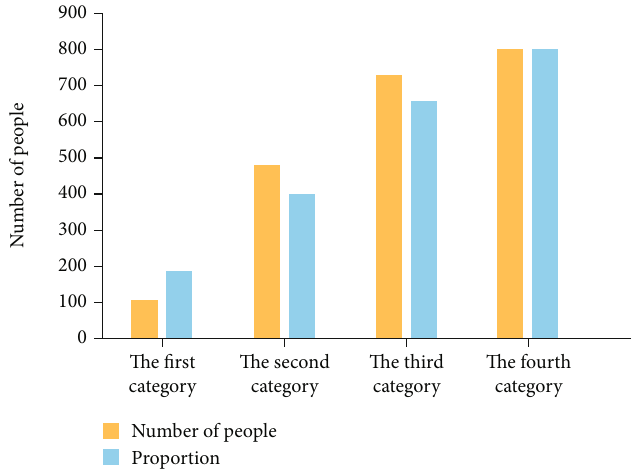
Figure 2: Cluster analysis of college students ’ mental health.